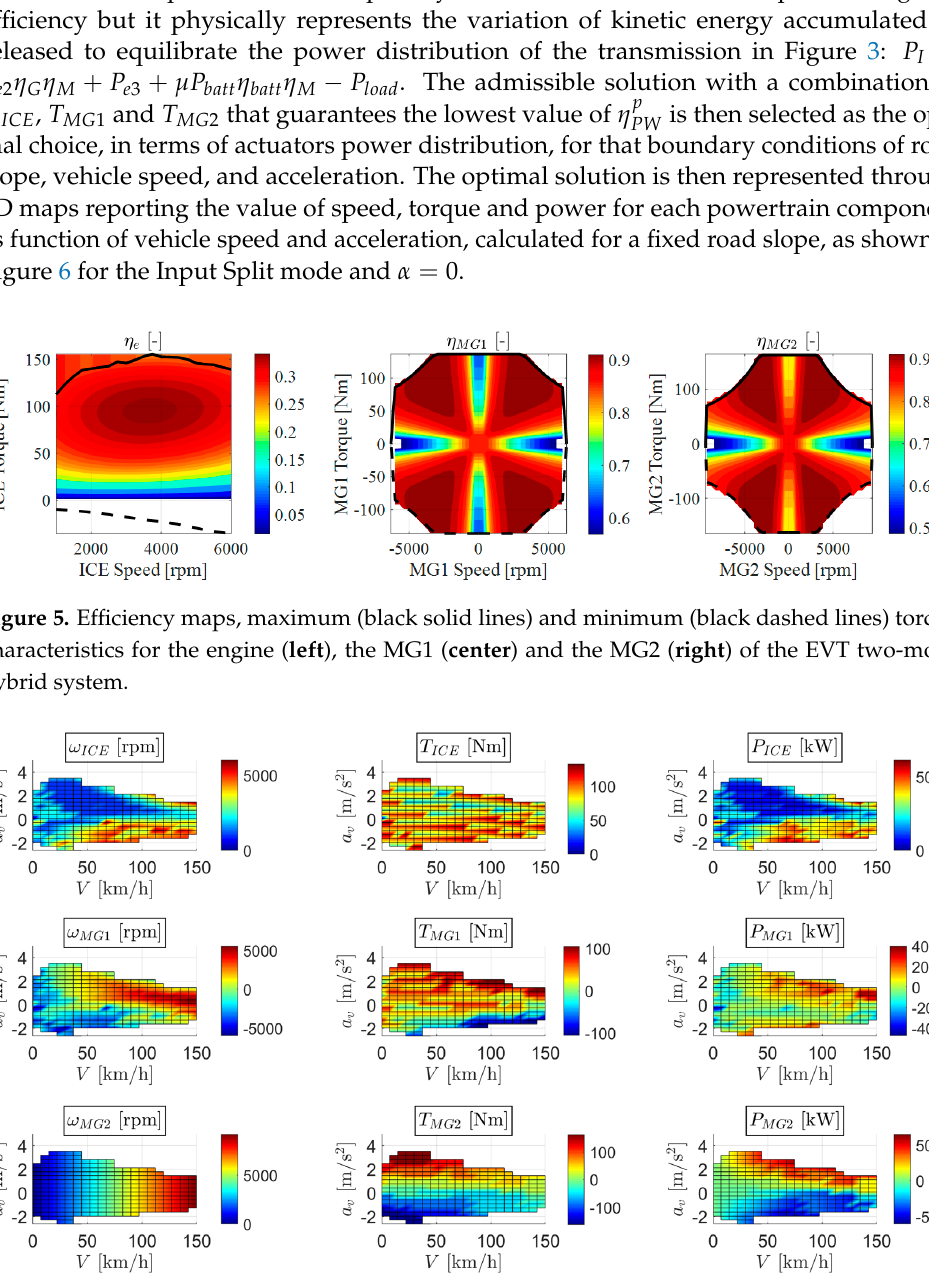
Figure 6. Angular speed ( left ), output shaft torque ( center ), and output shaft power ( right ) maps of the ICE ( top ), MG1 ( middle ) and MG2 ( bottom ) to achieve the lower penalized power-weighted efficiency for the Input Split mode and road slope α = 0